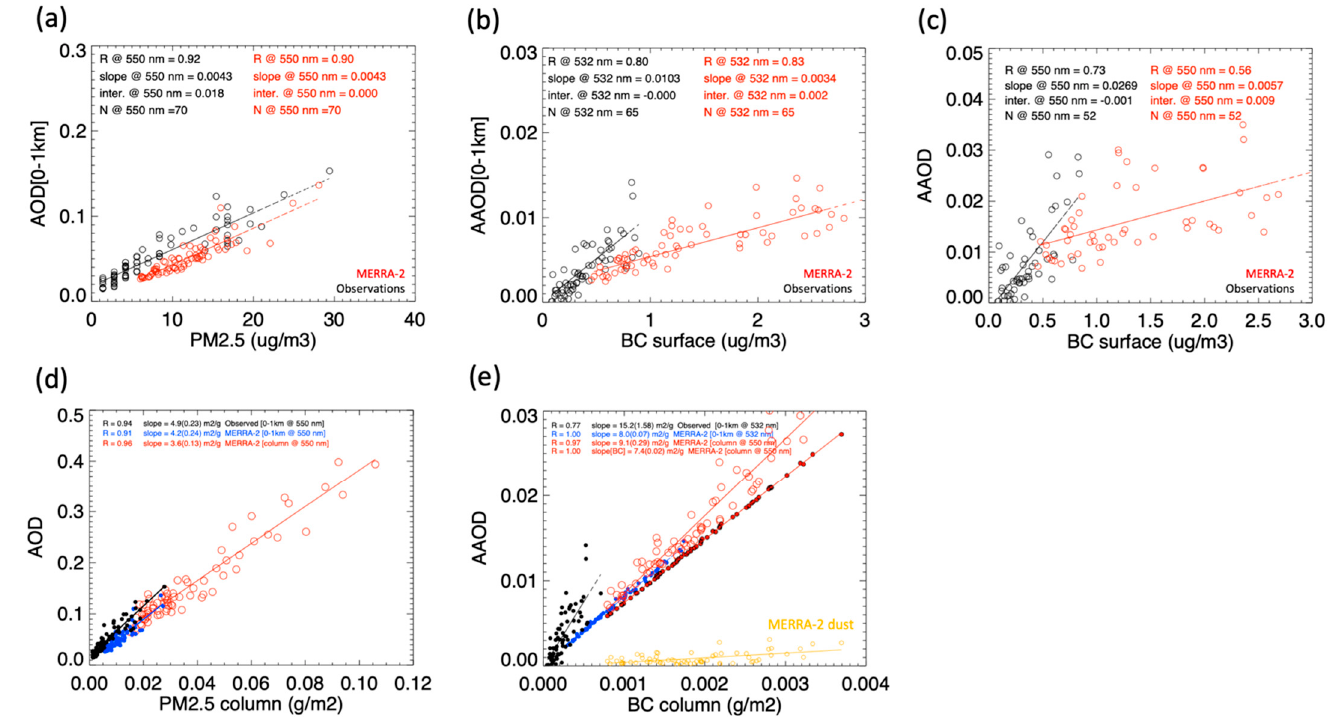
Figure 6. Scatter plots of PM2.5 surface concentrations and AOD[0–1 km] ( a ), BC surface concentrations and AAOD [0–1 km] ( b ), BC surface concentrations and the AAOD of the total column ( c ), PM2.5 total (red) or partial (black and blue) column concentrations and the AOD of the total or partial column ( d ), and BC total (red) or partial (black and blue) column concentrations and the AAOD of the total or partial column ( e ). In panel ( e ), scatter plots of the MERRA-2 AAOD of BC and BC total column concentration (small filled red points) and the AAOD of fine dust and BC total column concentration are also shown. Statistics are included in each panel. In panel ( d , e ) the “observed” PM2.5 and BC partial column was estimated by multiplying the measured surface concentration by the MERRA-based ratio of the mean concentration of the partial column to the surface concentration. Observations: black; MERRA-2 data: red (total column), blue (partial column). Only days with an AE > 1 and low RH are used. Days in panel ( c ) were further screened based on the AOD [0–1 km]/AOD ratio (see text for